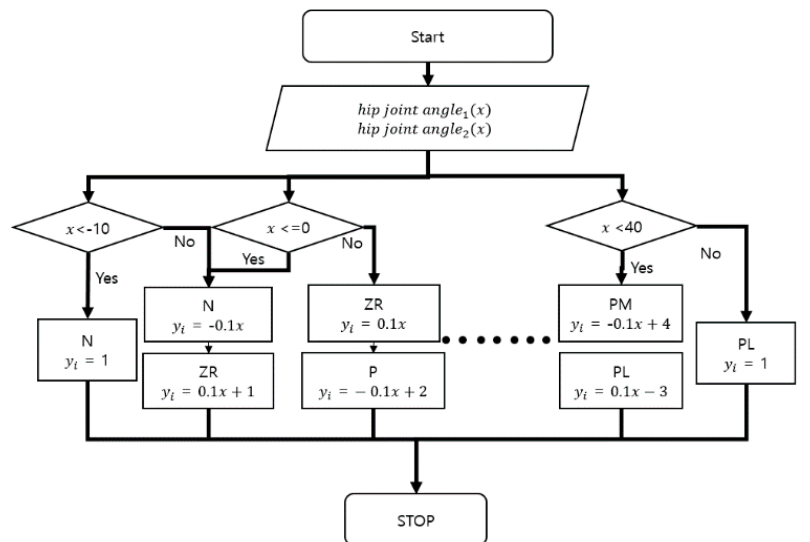
Figure 5. Input membership function of the fuzzy set: Hip joint angles. N, negative; ZR, zero; P, positive; PS, positive small; PM, positive medium; and PL, positive large.